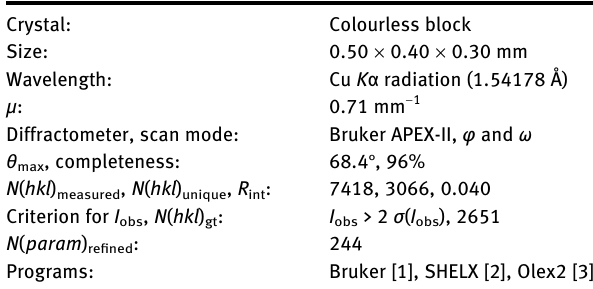
Table 1 contains crystallographic data and Table 2 contains